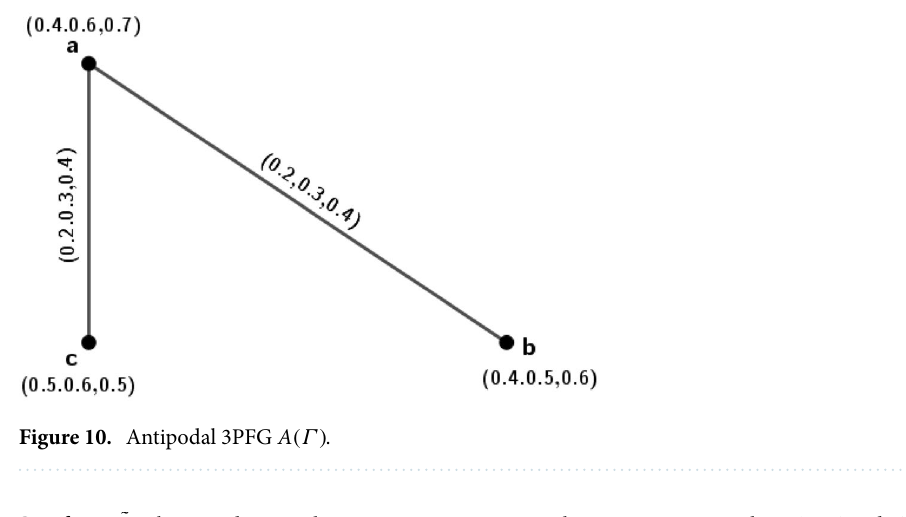
Figure 11. 3PFG Γ = (